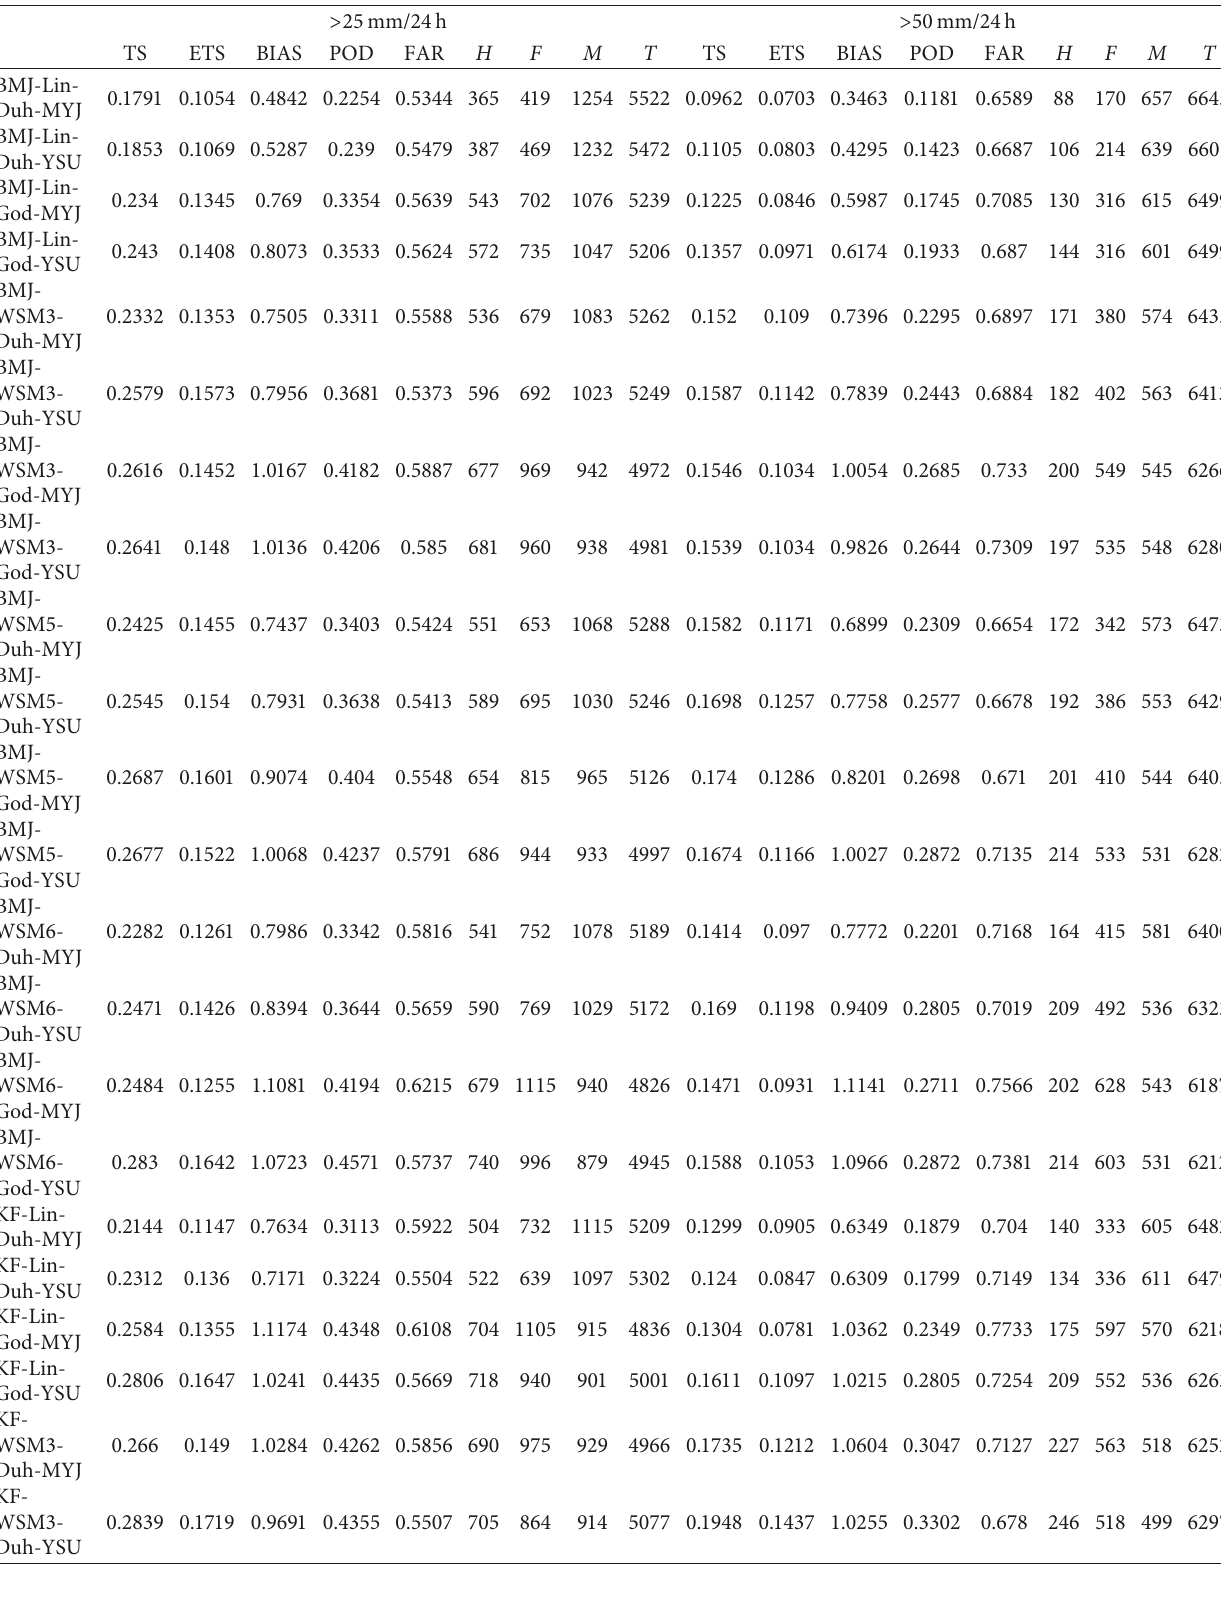
Table 5: Skill scores (TS, ETS, BIAS, POD, and FAR) and hit rates H , false alarm rates F , missed rates M , and total corrected rates Tat the 48h forecast range for thresholds > 25mm/24 h and > 50mm/24 h, for the period 2012–2016. The number of samples is